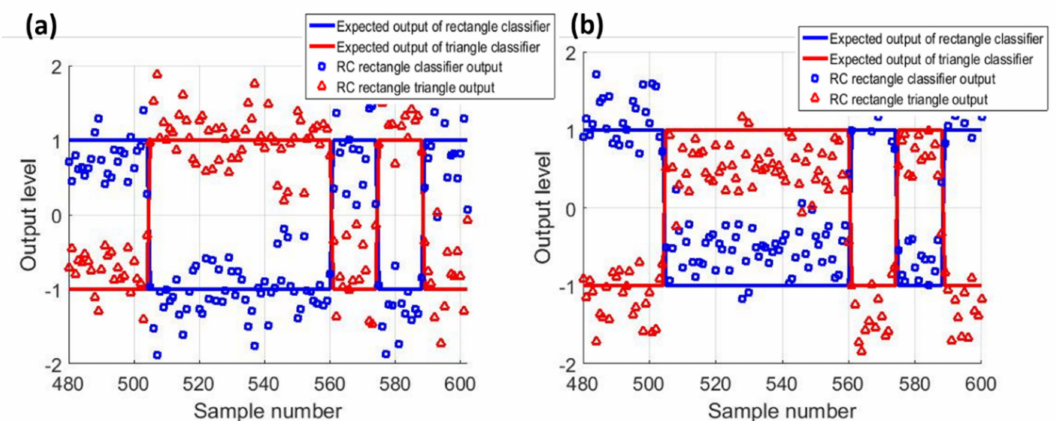
Figure 5. Experimental classification of low-frequency signal using the MEMS RC ( a ) under parameter (pressure) drift ( b ) and colored noise. The real-time results of the RC show success rates of 99.8% and 99.66%,